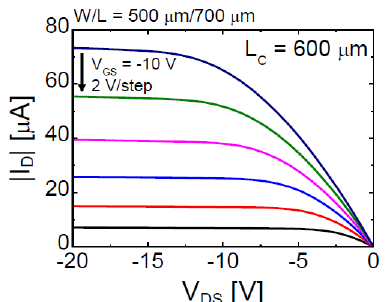
Figure 4. Output characteristic of fabricated p-channel SnO TFT with a floating Ni capping layer ( L C = 600 μ m).